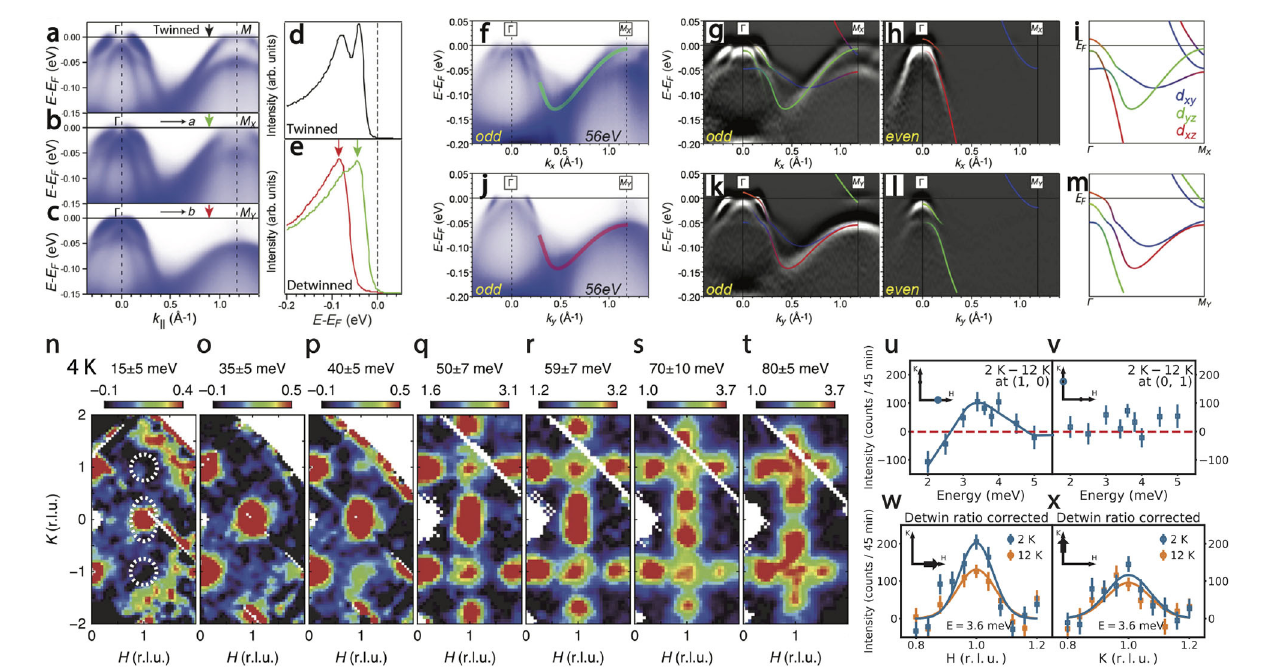
FIGURE 2 | ARPES and inelastic neutron spectra measured on twinned and detwinned FeSe [15, 46, 66]. (a) ARPES spectra taken along the Ŵ - M direction on a twinned FeSe. (b,c) ARPES spectra taken on detwinned FeSe along the Ŵ - M X and Ŵ - M Y directions, respectively. (d,e) Energy distribution curves taken at the momentum pointed to by arrows in (a–c) . The measurements are taken with 70 eV photons under odd polarization with respect to the cut direction. (f) Spectra measured along the Ŵ - M X direction with odd polarization. (g,h) Second energy derivatives of measured spectra along the Ŵ - M X direction under odd and even polarization with respect to the cut direction, respectively. A schematic of bands of orbital symmetries with the allowed intensity under each polarization is overlaid. (i) The complete band schematic from both polarizations is summarized Ŵ - M X . (j–m) A similar measurement as (f–i) but for the Ŵ - M Y direction. (n–t) Constant energy cuts in the [ H , K ] plane from the neutron scattering spectra of twinned FeSe [66]. Measurements in n-p and q-t were carried out at 4 K with E i = 79 and 294 meV, respectively. Symmetry equivalent data were pooled to enhance statistical accuracy. (u,v) Difference of the scattering below and above T c as a function of energy at Q AF = (1,0) and (0,1) measured in detwinned FeSe. The solid and dashed lines are guides to the eye. The peak 3.6 meV marks the neutron spin resonance. (w,x) Wave-vector scans with E = 3.6 meV at Q AF = (1,0) and (0,1). The trajectory of the scans (black errors) crossing spin excitations are illustrated in the insets. n-t are adapted from reference [66] with